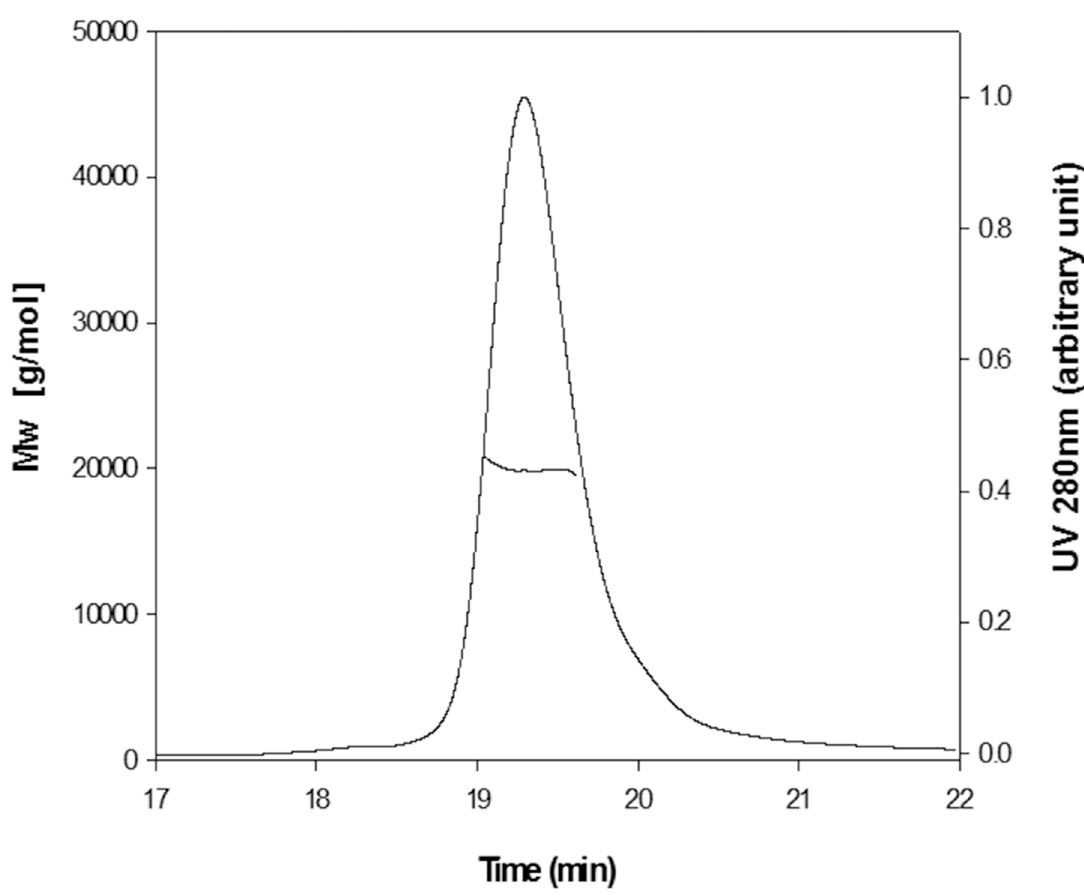
Fig 4. Oligomerization state of DUSP26-N (C152S) in solution as determined by SEC-MALS. The molecular mass of DUSP26-N (C152S) was calculated from the elution profile examined by analytical SEC-MALS. The molecular weight determined by SEC-MALS corresponds to a monomer of DUSP26-N (C152S). The corresponding theoretical mass of DUSP26-N (C152S) is 20,000